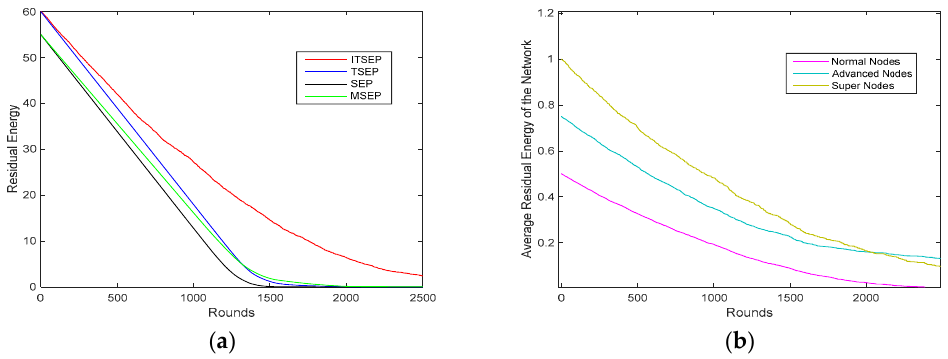
Figure 3. ( a ) Residual Energy; ( b ) Average Residual Energy of The Network. ITSEP: Improved Threshold-Sensitive Stable Election protocol; TSEP: Threshold-Sensitive Stable Election Protocol; SEP: Stable Election Protocol; MSEP: Modified Stable Election Protocol.